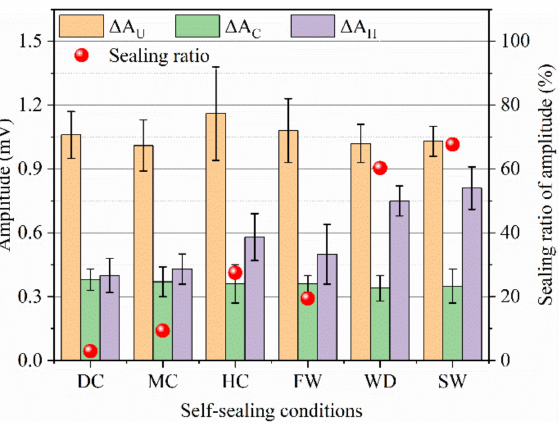
Figure 13. Self-sealing ratio based on the amplitude of dominant